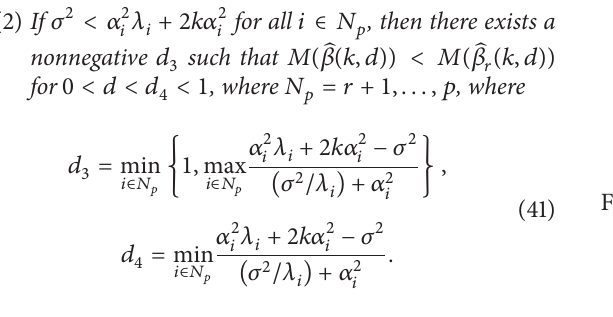
(2) If 𝜎 2 < 𝛼 2 𝑖 𝜆 𝑖 + 2𝑘𝛼 2 𝑖 for all 𝑖 ∈ 𝑁 𝑝 , then there exists a nonnegative 𝑑 3 such that 𝑀(